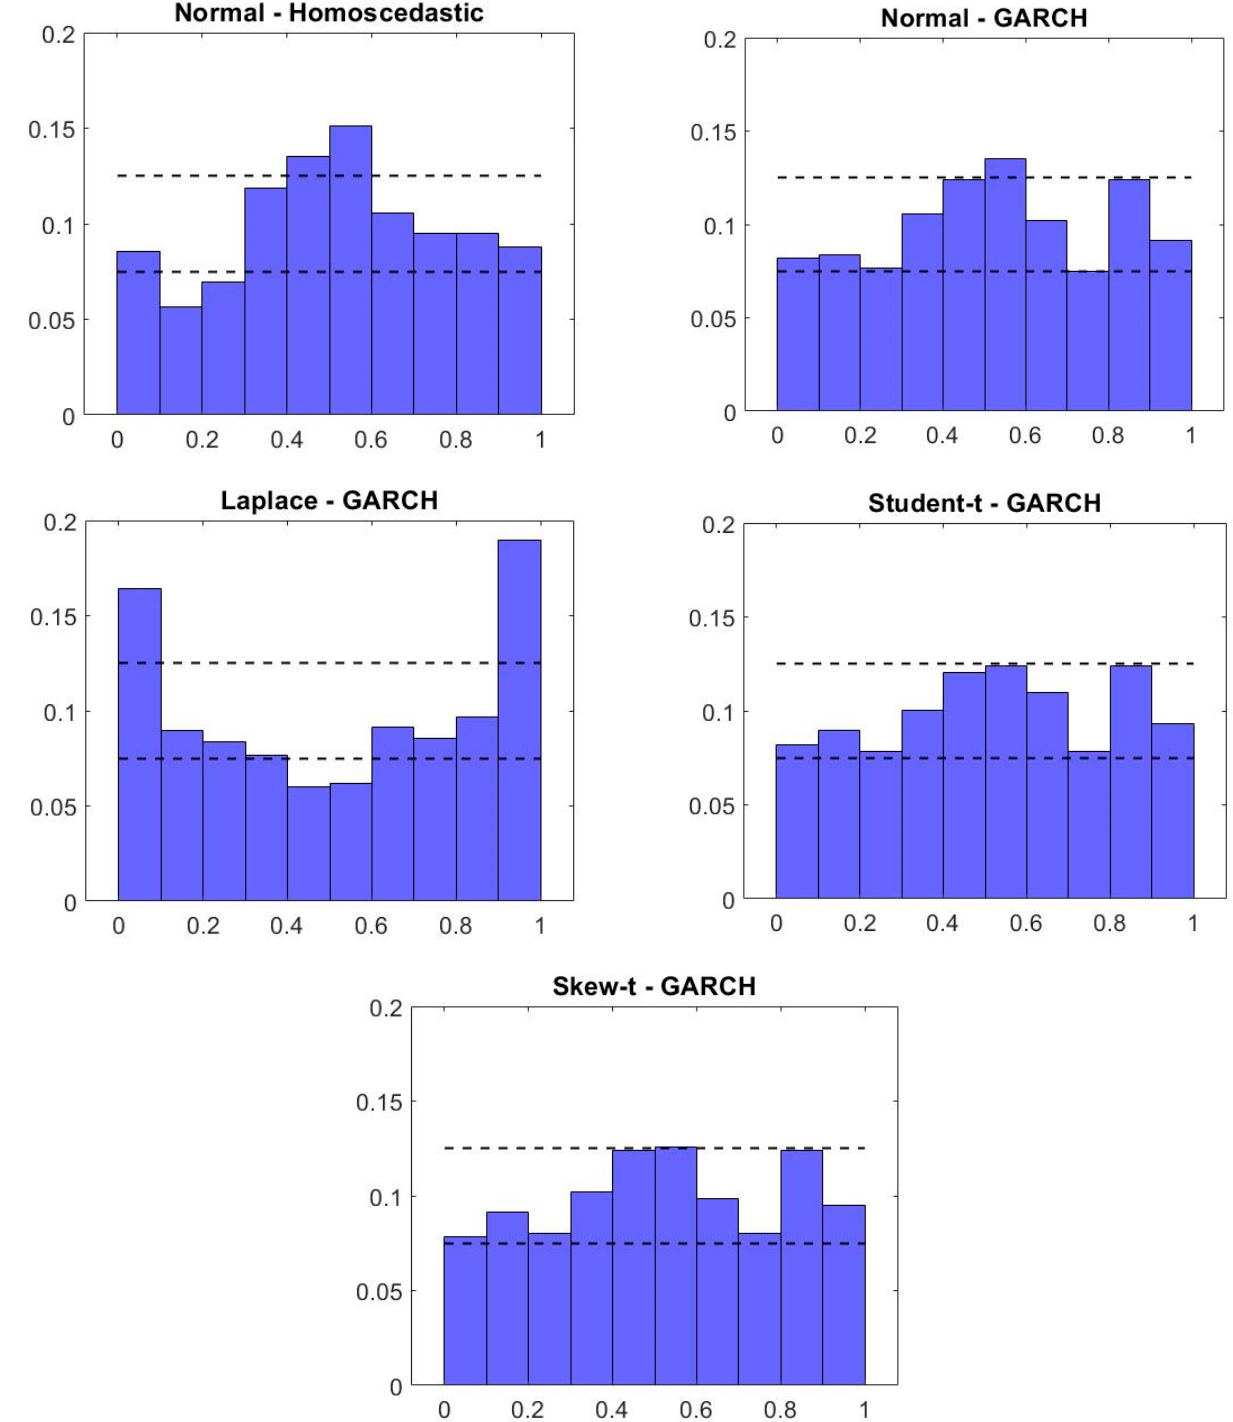
Figure A2. Histograms of probability integral transform for out–of–sample forecasts—real returns. Note: Relative frequency on vertical axis.